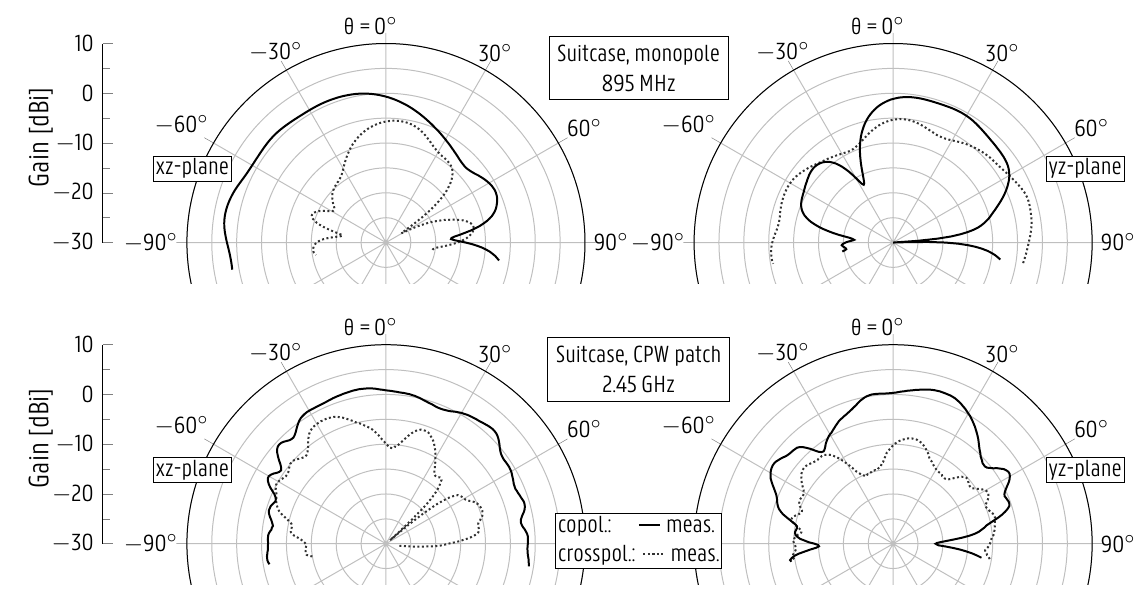
Figure 14. Measured radiation patterns of monopole and redesigned CPW patch antennas over- molded in the suitcase and interconnected by the interposer PCB. The coordinate system is defined individually at each antenna, as displayed in Figure 11, for consistency with the results presented in subsections Sections 4.1 and